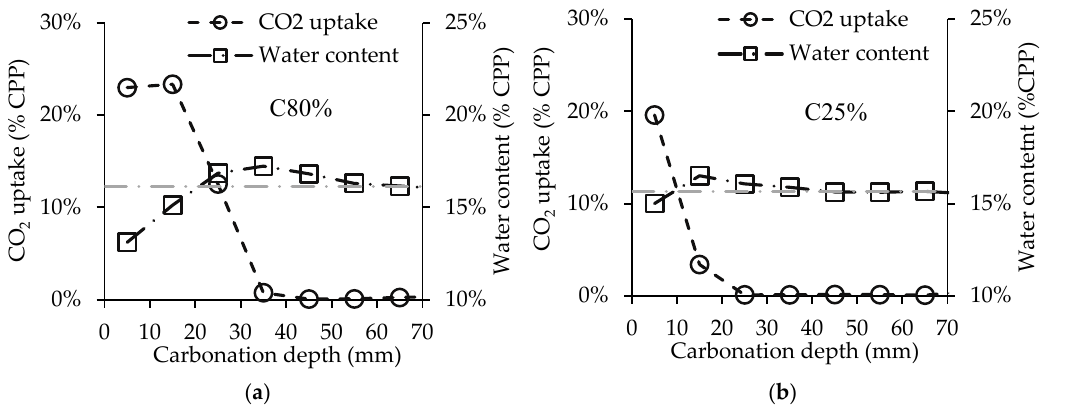
Figure 10. CO 2 uptake after 2 h over carbonation depth for 80% CO 2 ( a ) and 25% CO 2 ( b ) concentra- tions.